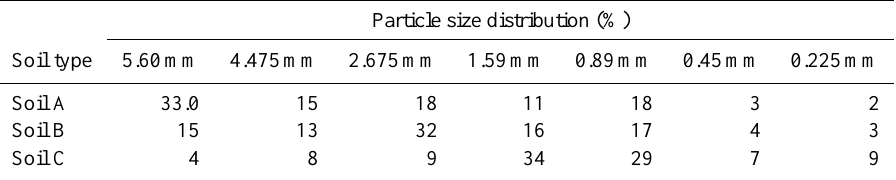
Table 3. Mean size distribution of soil aggregate